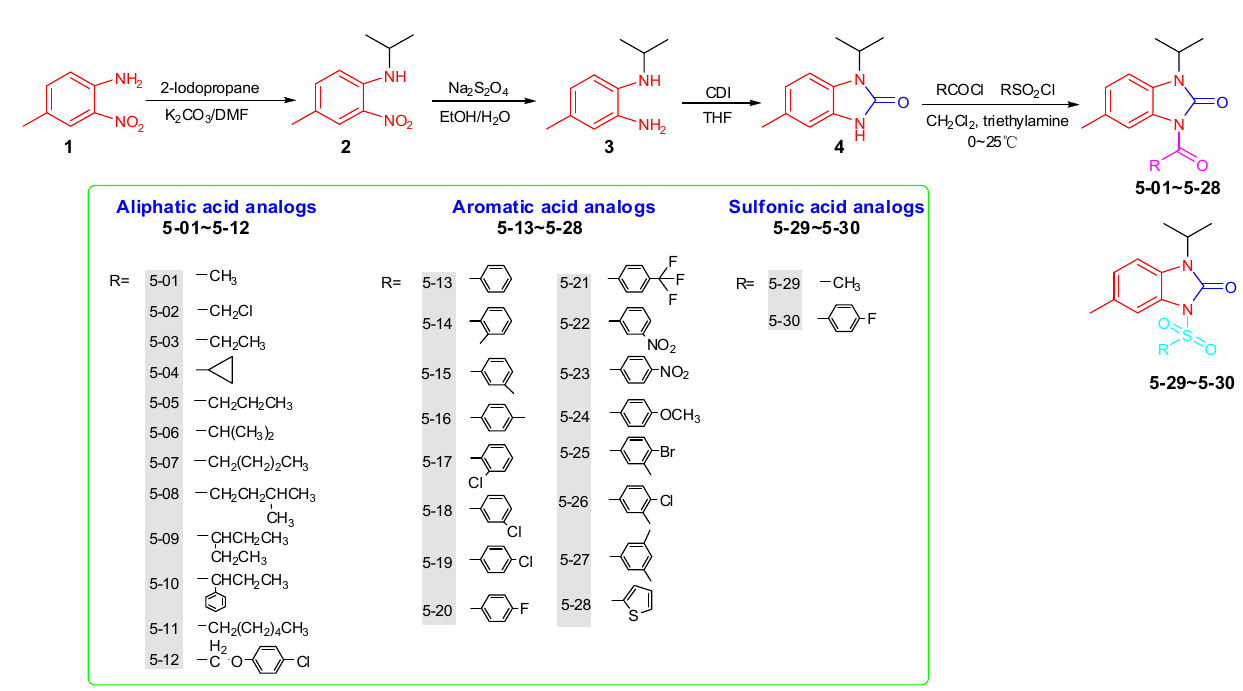
Scheme 1. Synthetic route of the title